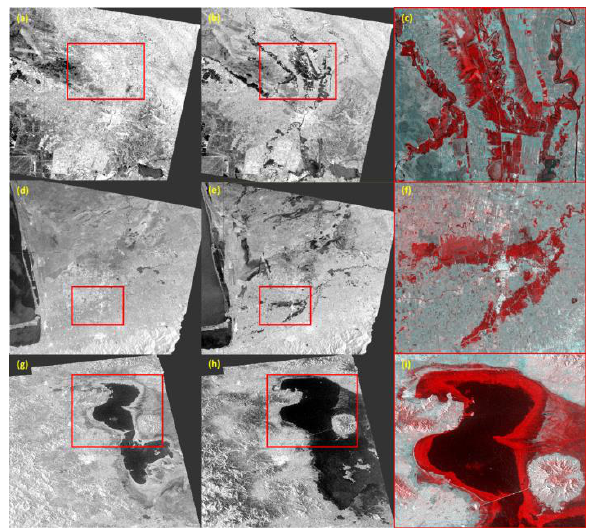
Figure 3. From left to right Archive and Crisis SAR images and the zoomed regions with a red border for the study areas. (a-c) Khuzestan, (d-f) Golestan and (g-i) Lake Urmia